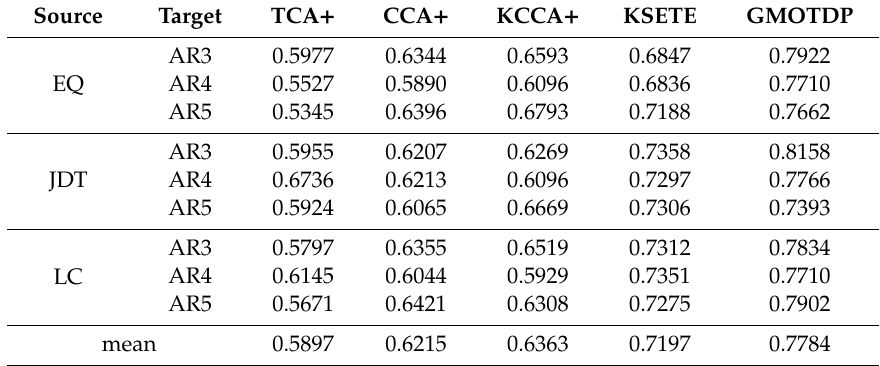
Table 8. Mean G-mean results for source and target projects without common features using di ff erent